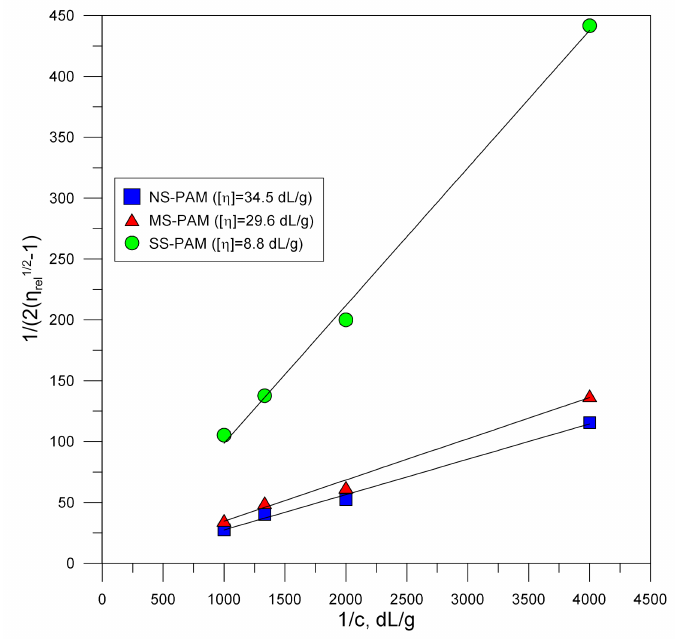
Figure 4. Plots of the left side of Equation (2) vs. 1 / c obtained for NS–PAM, MS–PAM, and